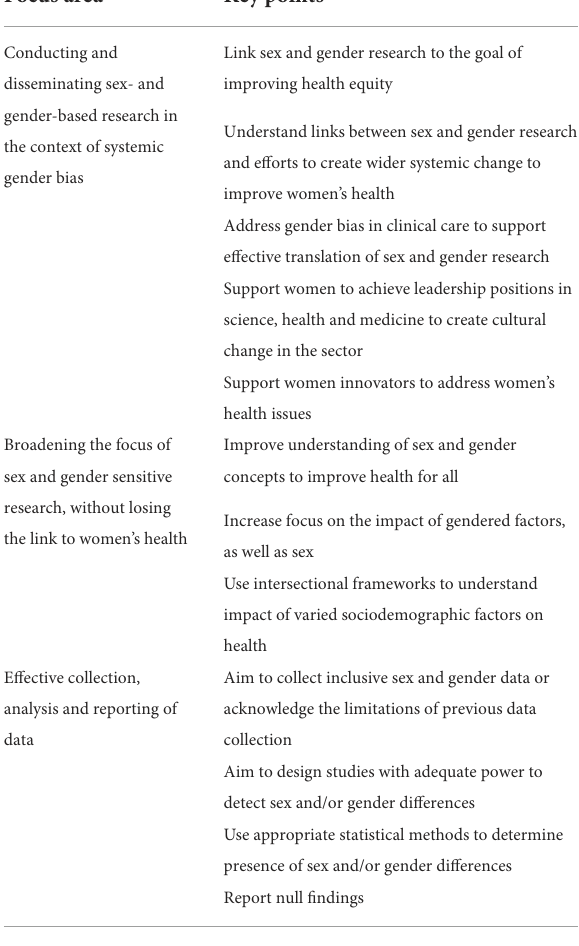
TABLE 1 Focus areas for the future of sex and gender research. Focus